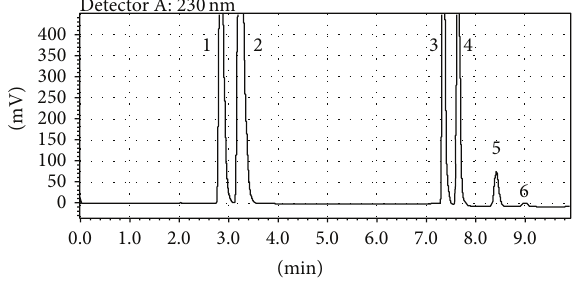
Figure 3: Chromatogram of synthetic standard mixture containing five food additives and caffeine recorded under optimized analysis conditions (1: sodium benzoate (15 𝜇 g/mL), 2: potassium sorbate (15 𝜇 g/mL),3:caffeine(15 𝜇 g/mL),4:ponceau4R(6 𝜇 g/mL),5:allura red (6 𝜇 g/mL), and 6: carmoisine (6 𝜇